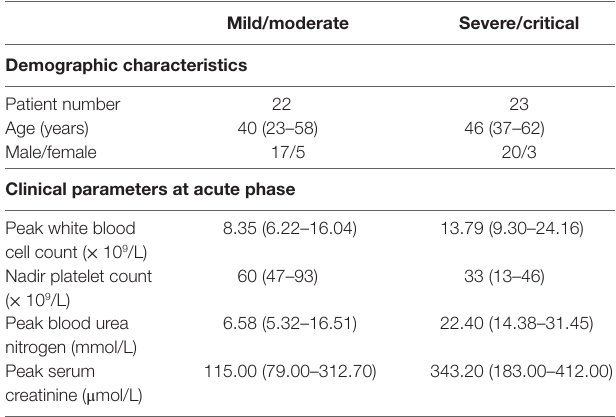
Table 1 | Information for the patients with hemorrhagic fever with renal syndrome in this